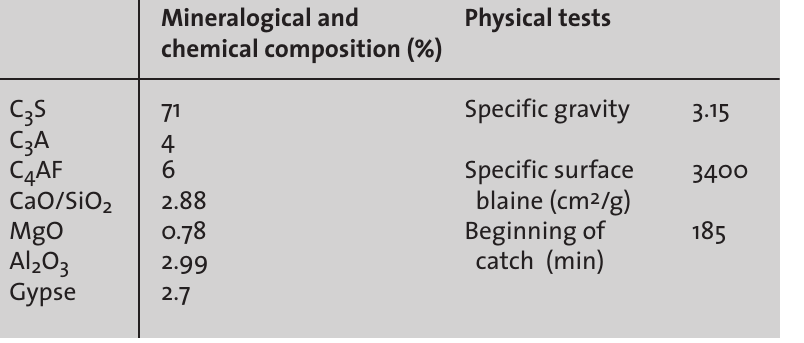
Table 2: Mineralogical, chemical and physical properties of the cement used in the present study.